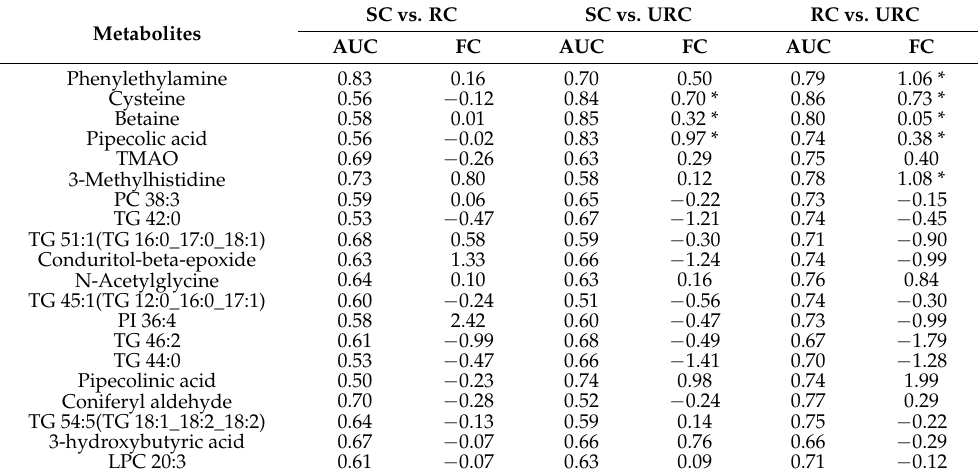
Table 3. Area under the curve–receiver operating characteristics (AUC-ROC) curve for the top 20 plasma